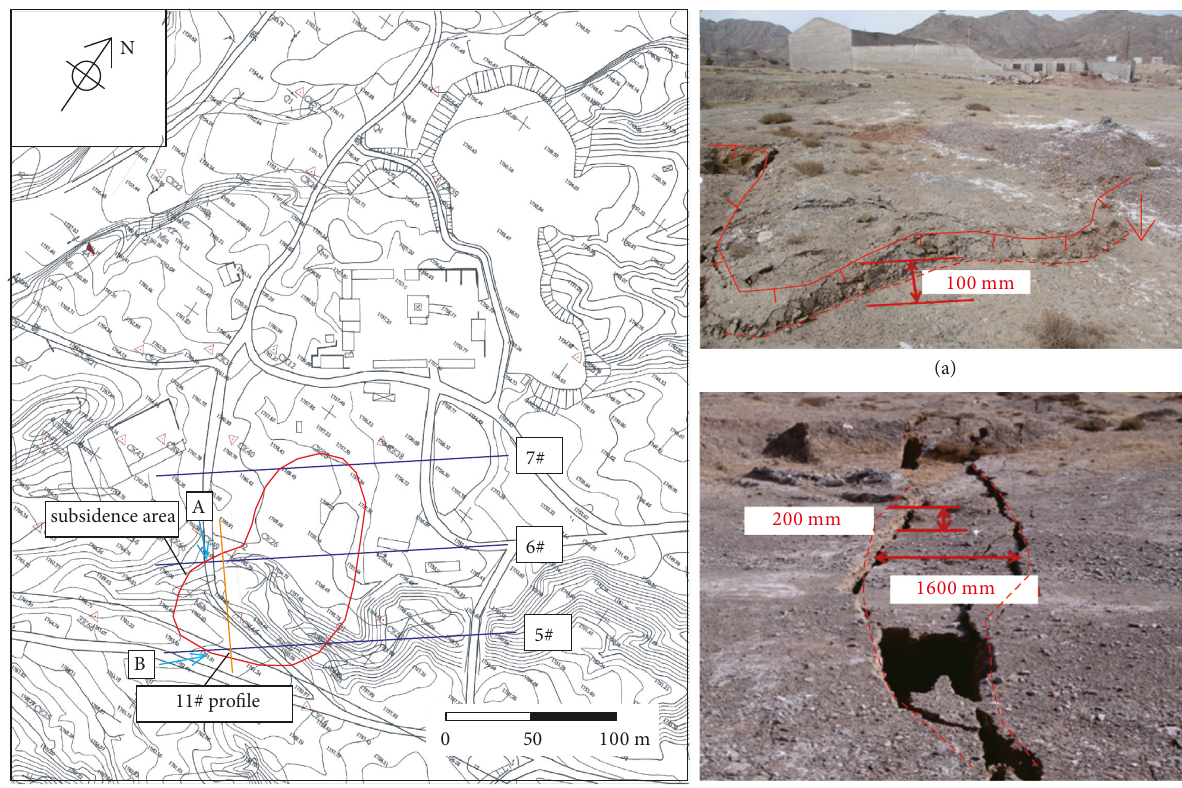
Figure 8: The location of the investigation and the damage at the site on the surface.